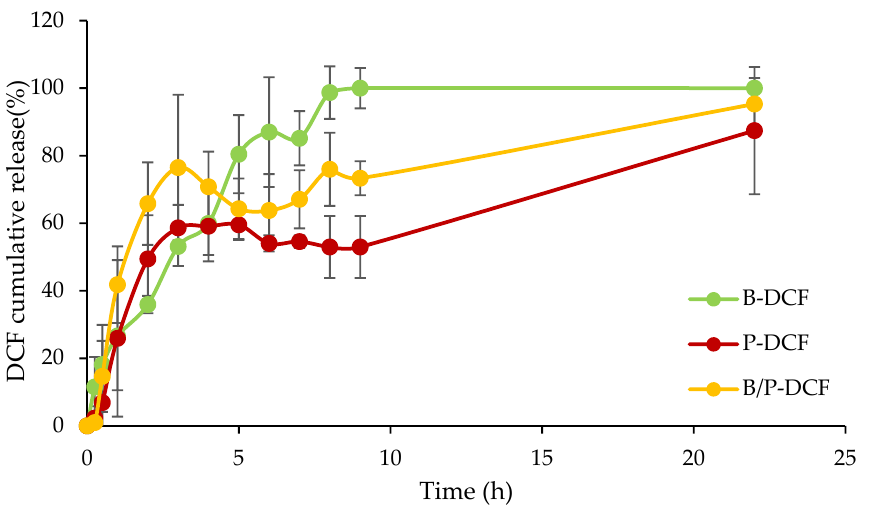
Figure 7. DCF cumulative release from B-DCF, P-DCF, and B/P-DCF gels (mean values ± s.d.; n = 3).